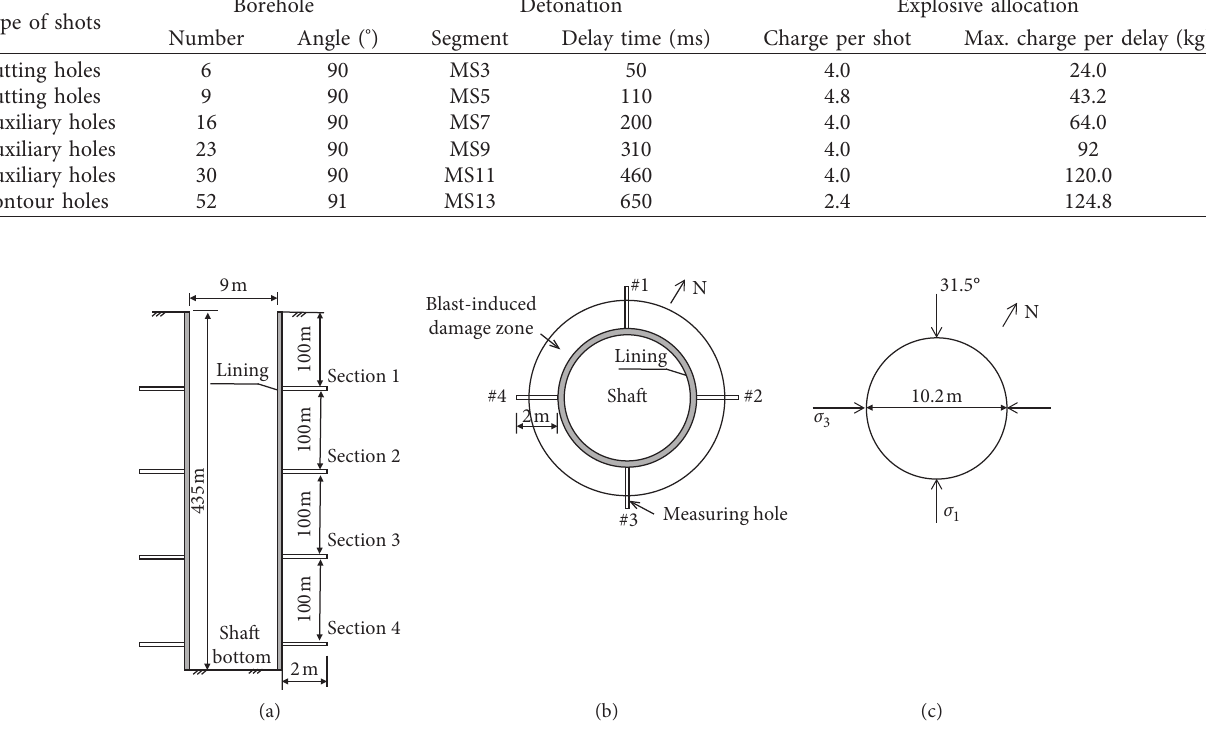
Figure 6: Sketch of the ultrasonic test hole layout (not to scale).